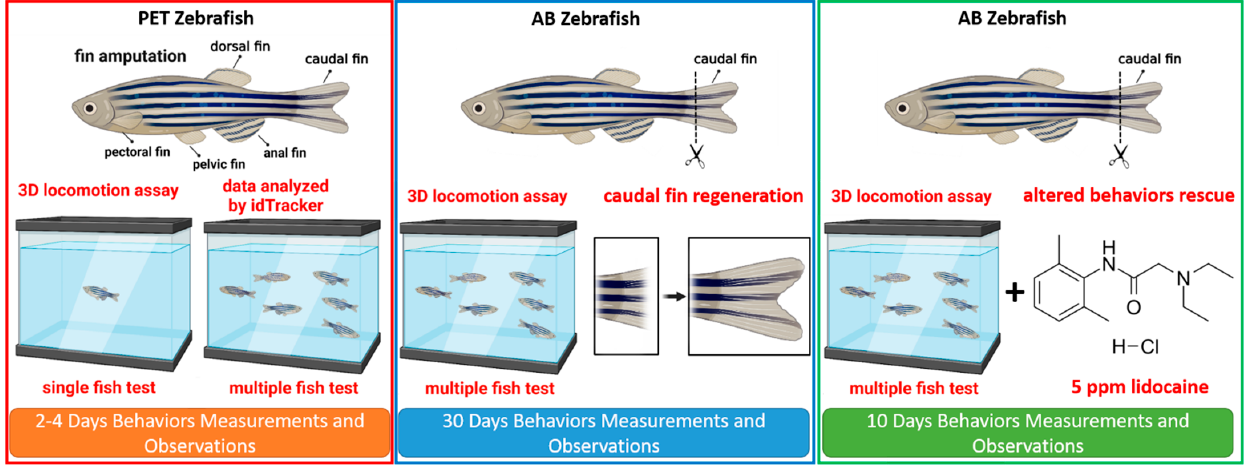
Figure 1. Overview of the experimental design of the current study. In the first section, each fin of the zebrafish was amputated, and the behavior performances of the amputated fishes were assessed in the 3D locomotion test individually and in a group. In the next section, one of the fins that affected the zebrafish behavior performance most was chosen as the fin of interest to evaluate the relation between behavior recovery and fin regeneration in zebrafish. Lastly, we observed the effect of lidocaine to help the fish recover their behaviors after the amputation.